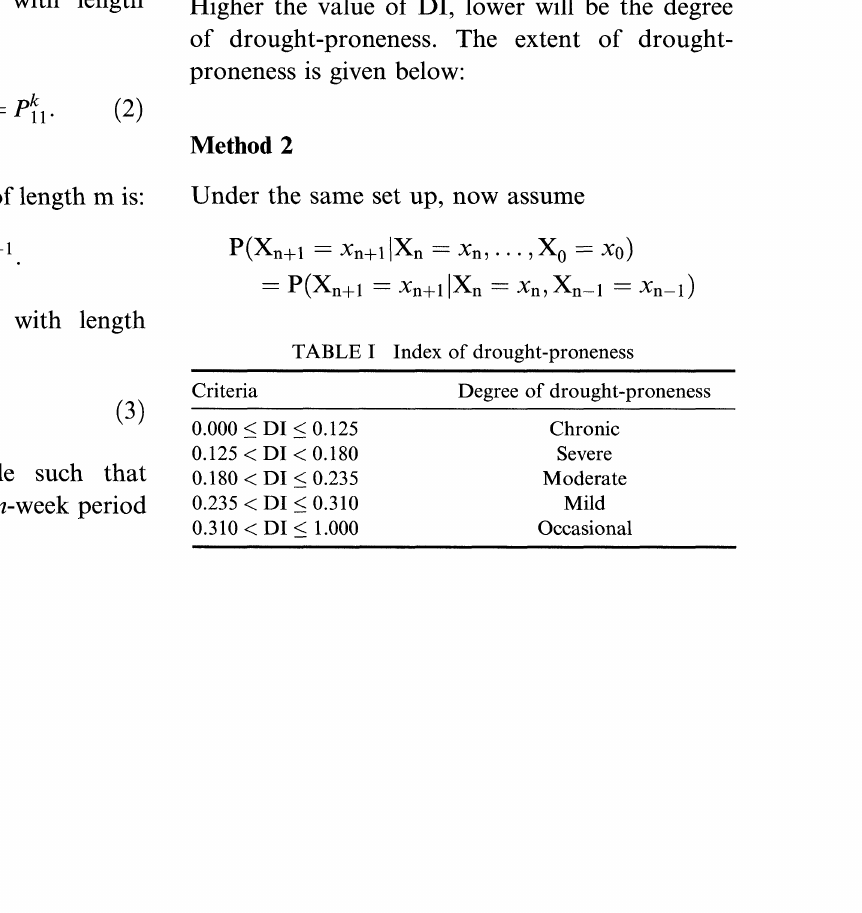
Index of drought-proneness